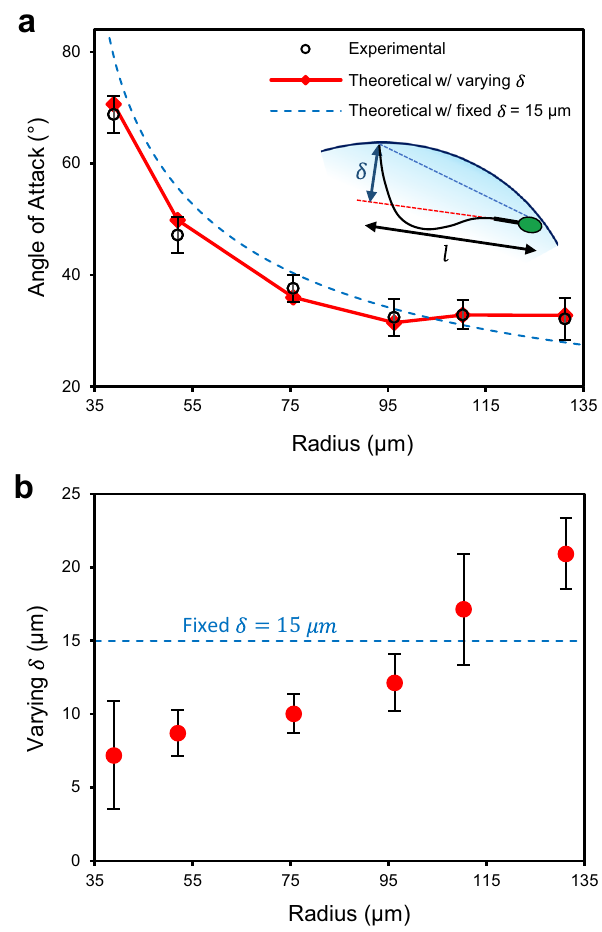
Fig. 5 Theoretical model for estimating the angle of attack. a Angle of attack from experimental measurements as compared with theoretical values with fi xed (dashed line) and varying (solid line) fl agellar wave amplitude, δ , as a function of droplet radius. Schematic representation of the reference system and modeled sperm shown by the inset. b Experimentally measured fl agellar wave amplitudes as a function of droplet radius. Values are reported as mean±s.d. ( n = 45 cells examined over 4 independent experiments). Source data are provided as a Source Data fi